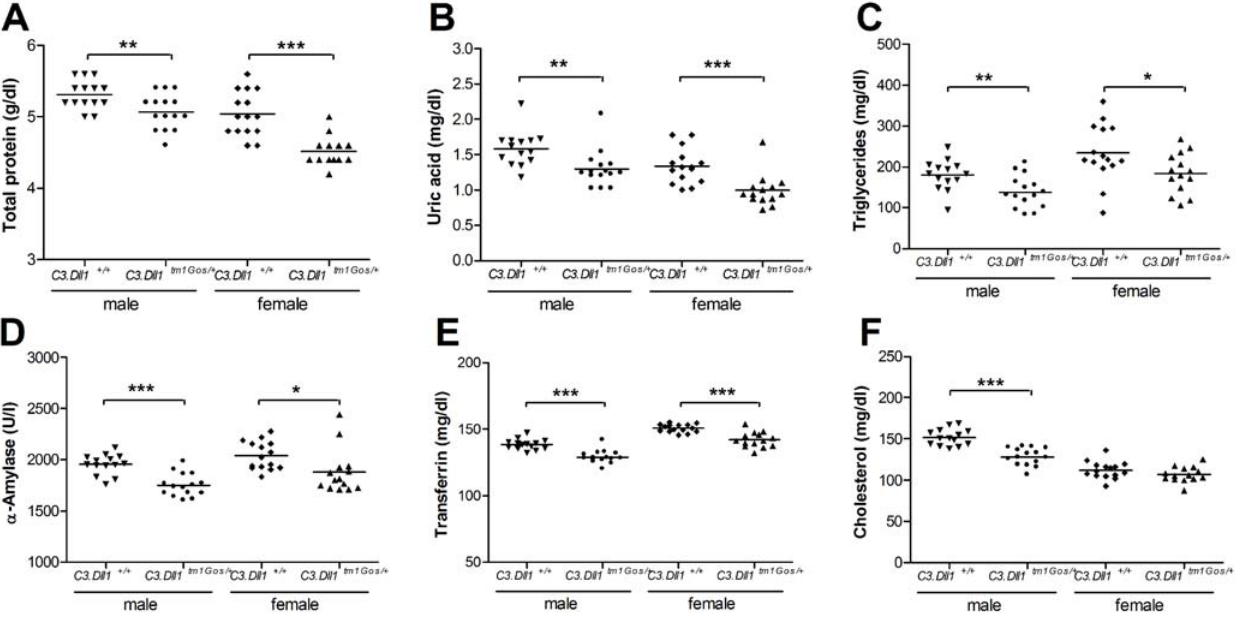
Figure 4. Selected clinical chemistry parameters in heterozygous C3.Dll1 tm1Gos animals and their wild-type littermates. A–F) Depicted are the scatter dot plot representations and the mean for each group: heterozygous C3.Dll1 tm1Gos/ + males (n=15) and their wild-type littermates ( C3.Dll1 + / + , n=14) and heterozygous C3.Dll1 tm1Gos/ + females (n=14) and their wild-type littermates ( C3.Dll1 + / + , n=15). P -value calculated performing unpaired t-test when variances were not significantly different. If significantly different then the Mann-Whitney test was performed. P -value: * P , 0.05, ** P , 0.01, *** P , 0.001.